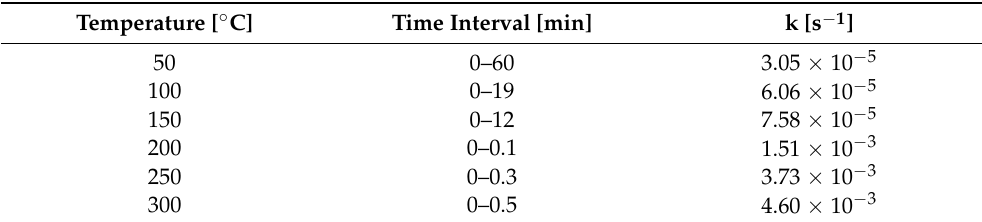
Figure 2b is the Arrhenius plot of ln ( k ) versus the inverse of temperature constructed with the estimated k’s . The activation energy of the hydriding reaction calculated from the slope is 63.8 ± 5.6 kJ/mol. Table 1. Rate constant at different temperatures for the hydriding reaction of cryogenically prepared Mg-15wt.% VCl 3 . Temperature [ ◦ C] Figure 2. ( a ) Isothermal hydrogen uptake versus time. ( b ) Fitting to contracting volume, diffusion- controlled 3D growth with decreasing interface velocity model. Black lines indicate the fitting neigh- borhood (i.e., just a guide for the eye) for the 300, 250, and 200 °C curves. Inset of ( b ): Arrhenius plot of ln ( k ) versus the inverse of temperature for hydriding reactions of cryogenically prepared Mg- 15wt.% VCl 3 .